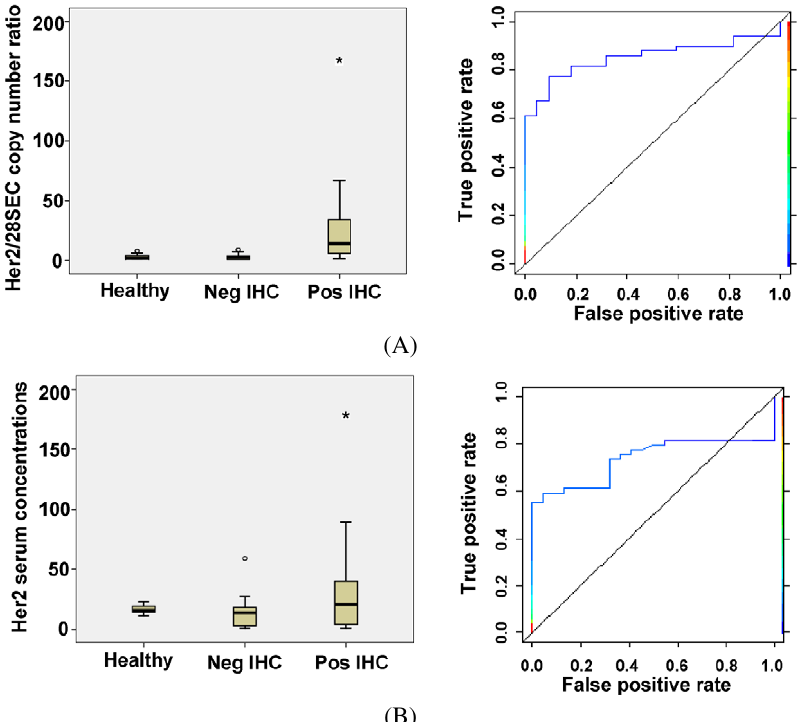
Fig. 1. (A, left panel) Box plot for the HER2/28SEC copy number ratios determined by QPCR for the three groups of patients. The lines inside the boxes denote median values. The whiskers represent the interval between the 10th and 90th percentiles. The empty circle indicate the outliners values between 1.5 and 3 length upper or down from the interquartile range. “*” Indicates the extreme cases with more than three boxes length upper or down from the interquartile range. (A, right panel) ROC curve for QPCR assay was designed on the basis of HER2/28SEC copy number ratios in IHC 3 + positive tumours and healthy controls. The area under the curve is 0.85 ( p < 0 . 001). (B, left panel) Box plot for the HER2 serum concentrations determined by EIA for the three groups of patients. The lines inside the boxes denote median values. The whiskers represent the interval between the 10th and 90th percentiles. The empty circle indicate the outliners values between 1.5 and 3 length upper or down from the interquartile range. “*” Indicates the extreme cases with more than three boxes length upper or down from the interquartile range. (B, right panel) ROC curve for QPCR assay was designed on the basis of HER2/28SEC copy number ratios in IHC 3 + positive tumours and healthy controls. The area under the curve is 0.85 ( p < 0 .